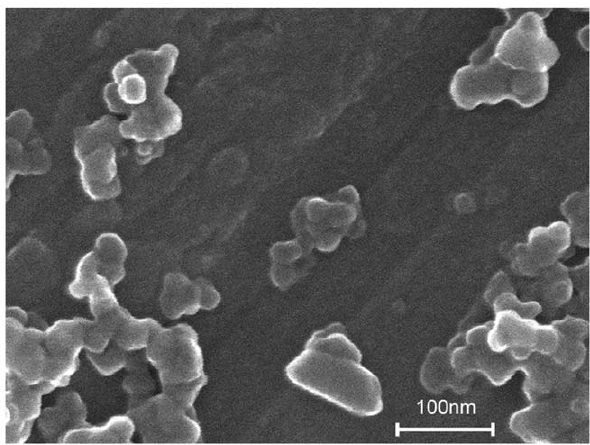
Figure 2. The experimental set-up. The flow-through testing apparatus, showing four experimental units (volume, 500 mL) with five D. magna each. Approximately 40 mL of the test medium was introduced every other hour slightly below the surface of the water. The old test medium was passively discharged using hydrostatic pressure at the bottom of each vessel. A fine mesh screen (0.1 mm) prevented the loss of recently hatched juvenile daphnids.